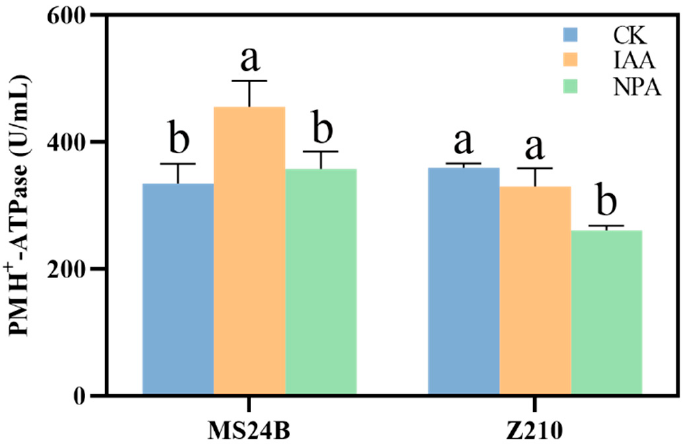
Figure 7. The effect of IAA and NPA on PM H + -ATPase activity in line MS24B and Z210. Lowercase letters indicate statistical differences ( p ≤ 0.05) among treatments.